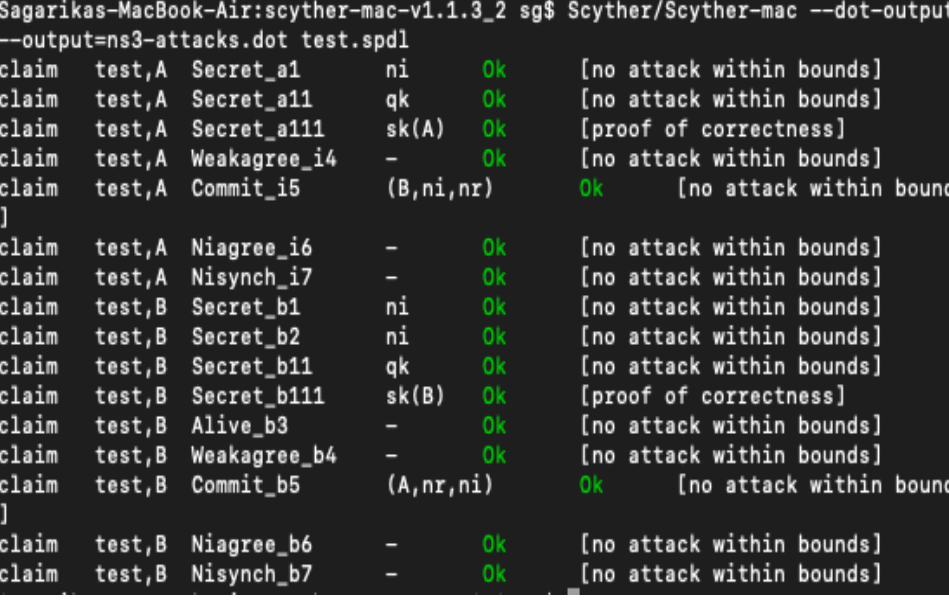
Figure 11. The encryption and signature phase verified by Scyther tool.